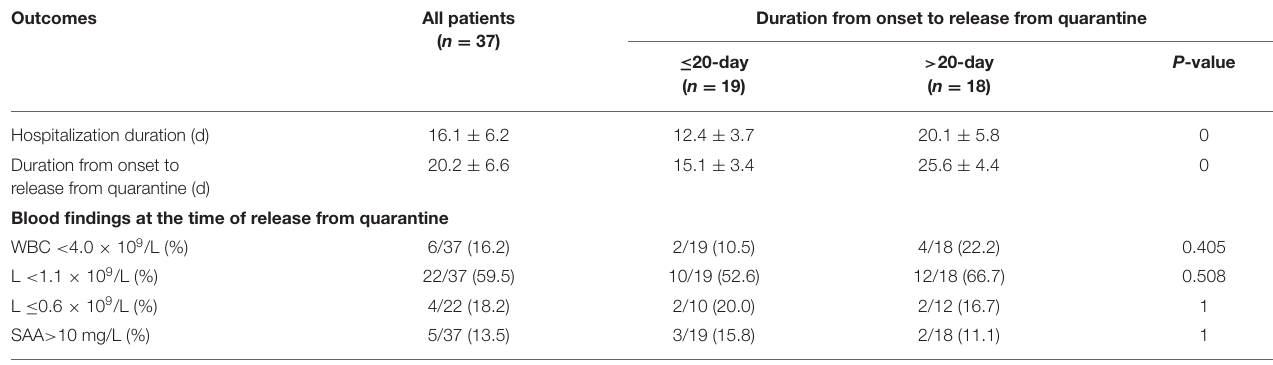
TABLE 3 | Clinical outcomes of patients. Outcomes